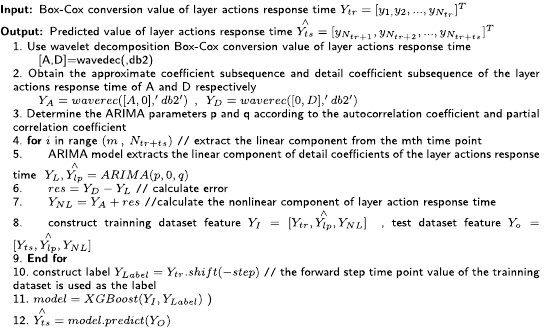
Algorithm 1 WT‑ARIMA‑XGBoost Hybrid PredictionExperiment and